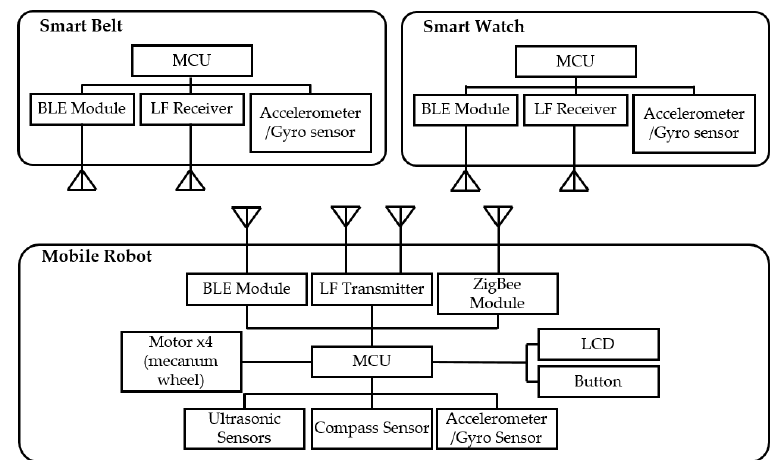
Figure 14. Hardware configuration of the mobile robot system.